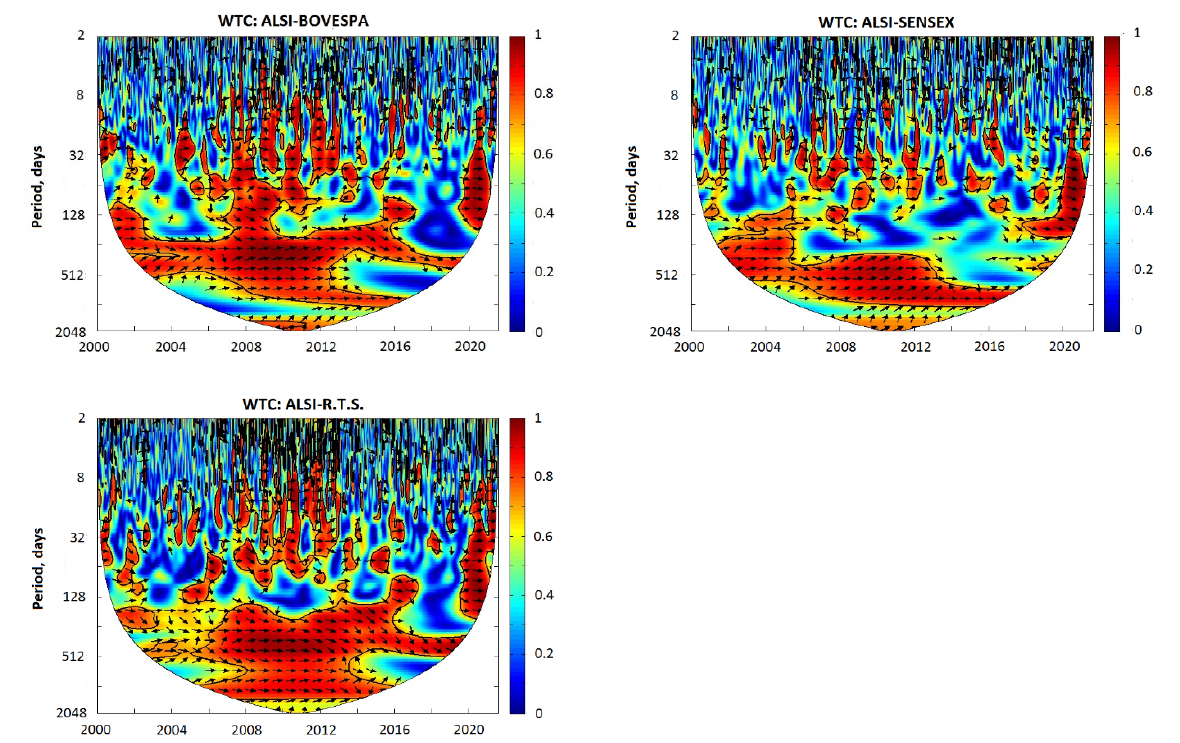
Figure 4. Wavelet squared coherence of stock returns of South Africa with Brazil, India and Russia. The comovement level is measured in the range of lower correlation (blue) to higher correlation (red), as shown in the colour bar. The thick black contour indicates a 5% significance level against red noise. The relative phase relationship is shown as pointing arrows. Down: the first series leading the second series by 90°; up: the second series leading the first series by 90°; right: in-phase; left: antiphase.